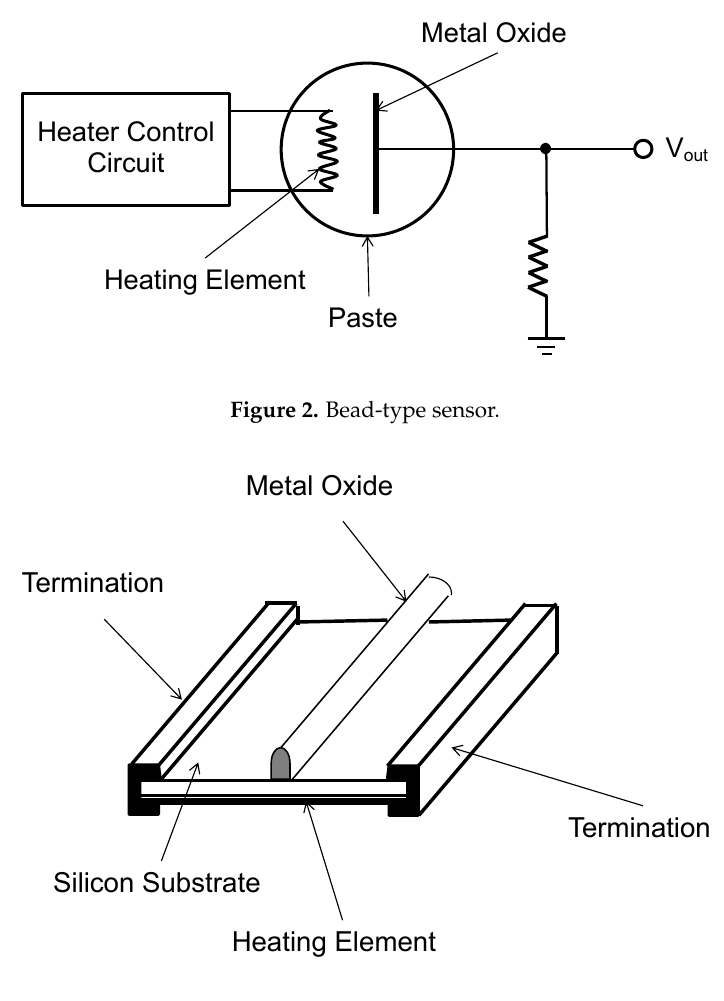
Figure 3. Chip-type